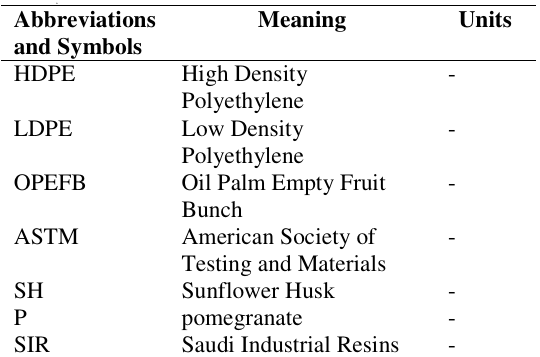
Table 1, List of abbreviations and